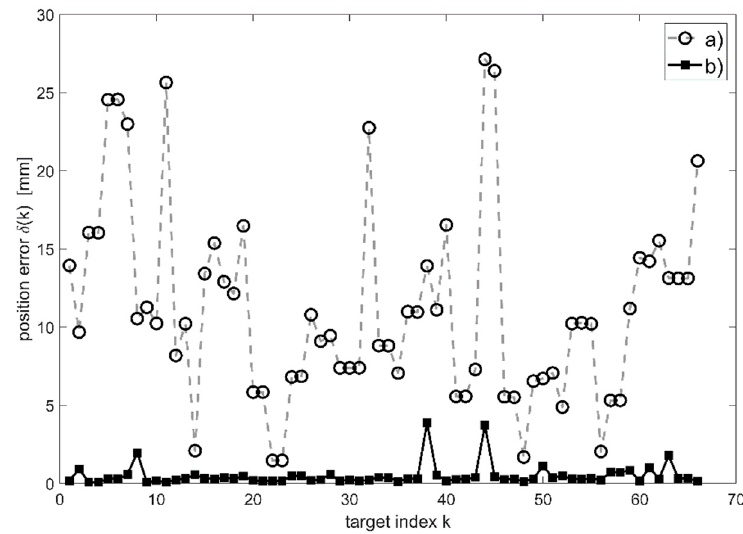
Figure 11. Target position error calculated from data acquired in [16] with the motion capture system: ( a ) uncorrected error δ unc ; ( b ) corrected error δ cor .